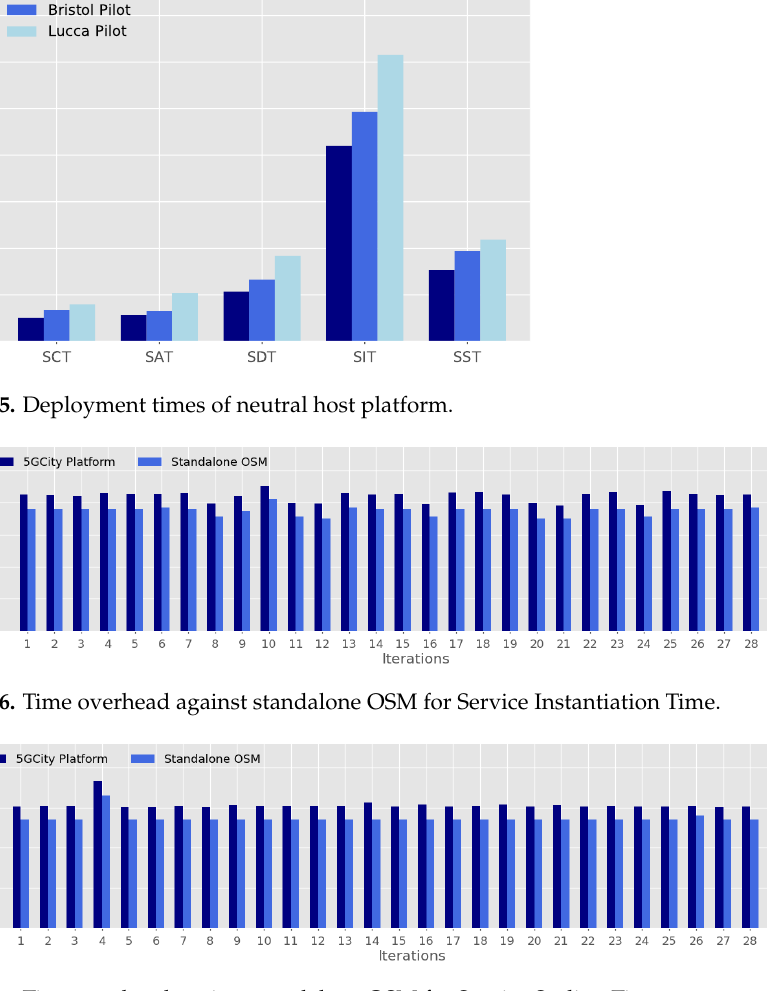
Figure 7. Time overhead against standalone OSM for Service Scaling